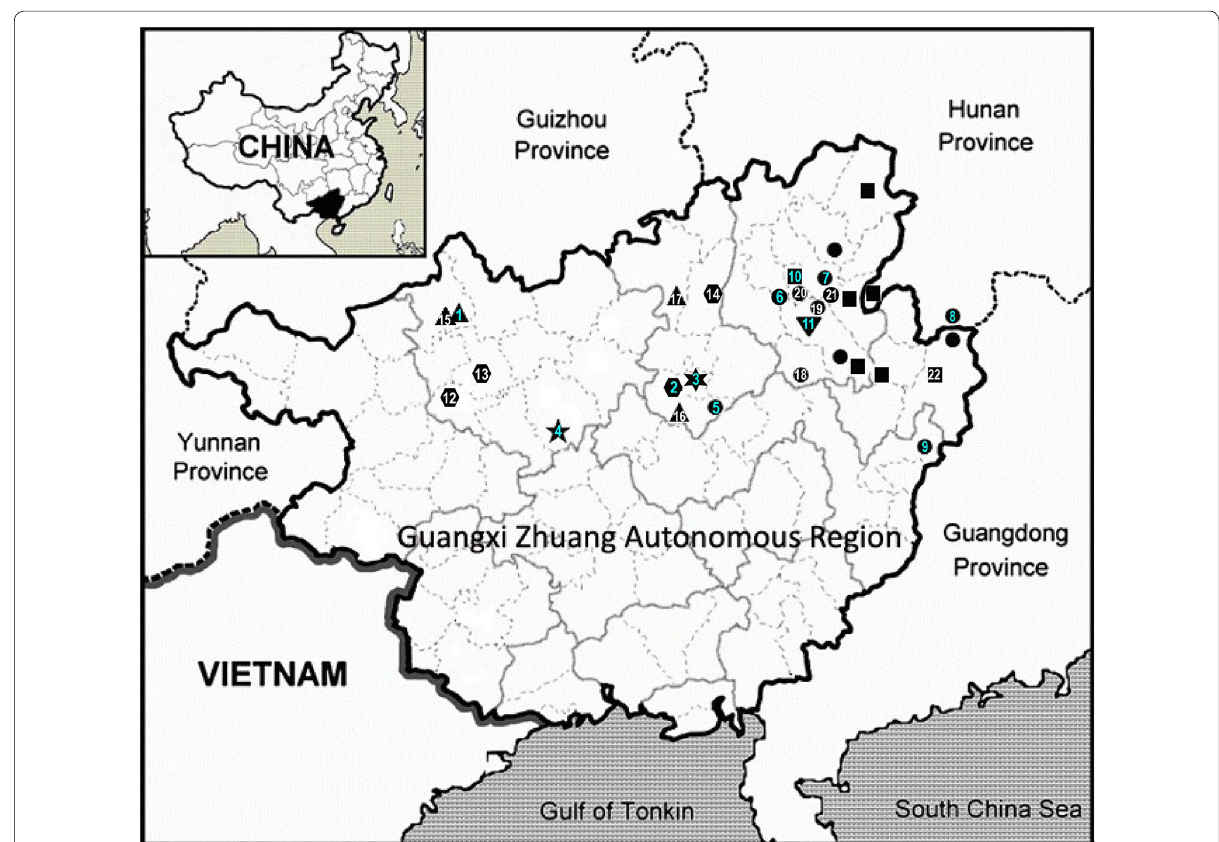
Fig. 5 Distribution of Primulina bipinnatifida (black circles), P. chingipengii (black star), P. cordifolia (hexagons), P. huangii (hexagram), P. subulata var. guilinensis (black squares), P. pseudoglandulosa (black down‑pointing triangle) and P. repanda (black up‑pointing triangles) in Guangxi and Hunan, southern China. The type localities are marked by the light‑blue numbers (1–11): 1. Chiritopsis repanda ; 2. C. cordifolia ; 3. P. huangii ; 4. P. chingipengii ; 5. P. bipinnatifida var. zhoui ( P. zhoui ); 6. C. bipinnatifida ; 7. C. lingchuanensis ; 8. P. jianghuaensis ; 9. P. cangwuensis ; 10. C. repanda var. guilinensis ; 11. C. ≡ glanduola var. yangshuoensis . Numbers 12 to 22 denote non‑type localities sampled for current study: 12: Bama ( Chung 1828 ); 13: Wuzhuang (